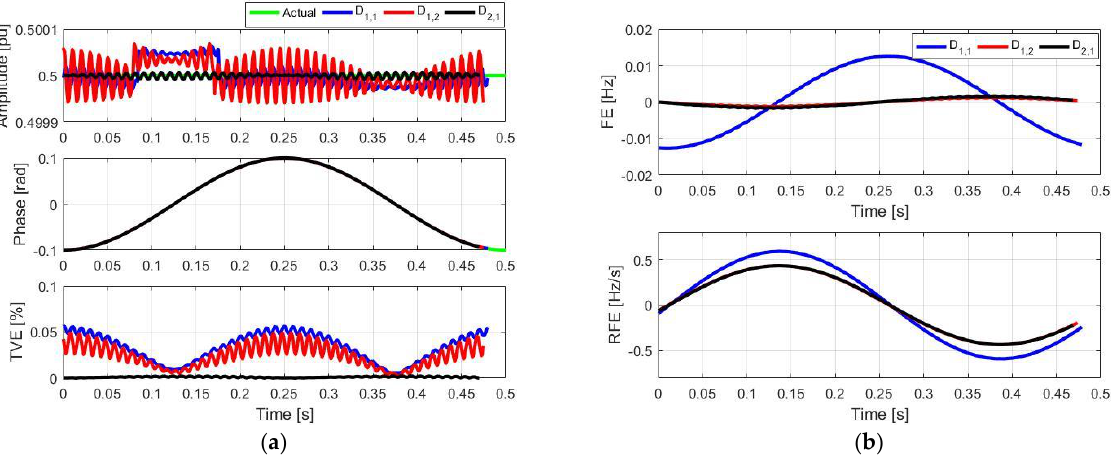
Figure 7. Simulation results obtained for the phase modulated signal with f m = 2 Hz, for K = 1 for D 1,1 = 16 and D 1,2 = 20, and K = 2 for D 2,1 = 24, with f 1 = 50 Hz and f S = 800 Hz ( N = 16 ) : ( a ) amplitude, phase and TVE, and ( b ) FE and RFE.